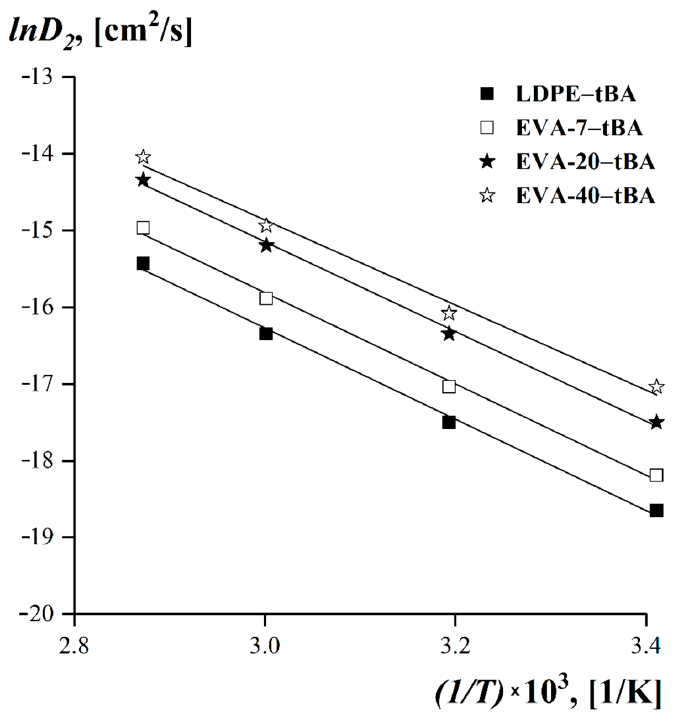
Figure 11. Temperature dependences of the limiting interdiffusion coefficients at ϕ tBA → 0 for LDPE– tBA, EVA-7–tBA, EVA-20–tBA, and EVA-40–tBA systems.